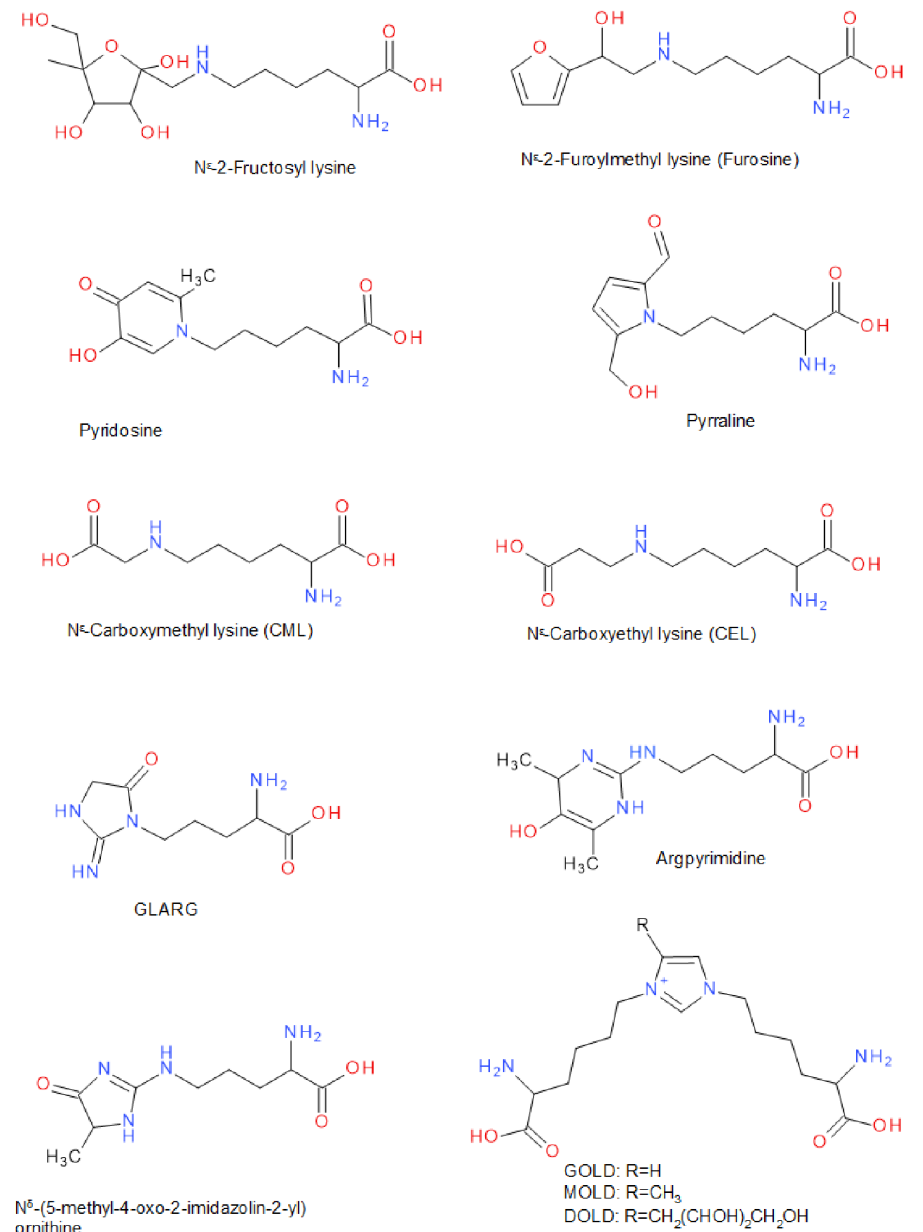
Figure 2. Typical compounds related to post-translational protein modification of lysine or arginine residues in the Maillard reaction involving carbohydrates. Abbreviations: GLARG: 1-(4-amino-4-carboxybutyl)-2-imino-5-oxo-imidazolidine; GOLD: glyoxal-derived lysine dimer, 1,3-di(N ε -lysino)-imidazolium salt; MOLD: methylglyoxal-derived lysine dimer, 1,3-di(N ε -lysino)-4-methyl-imidazolium salt; DOLD: 3-deoxyglucosone-derived lysine dimer, 1,3-di(N ε -lysino)-4-(2,3,4-trihydroxybutyl)-imidazolium salt.